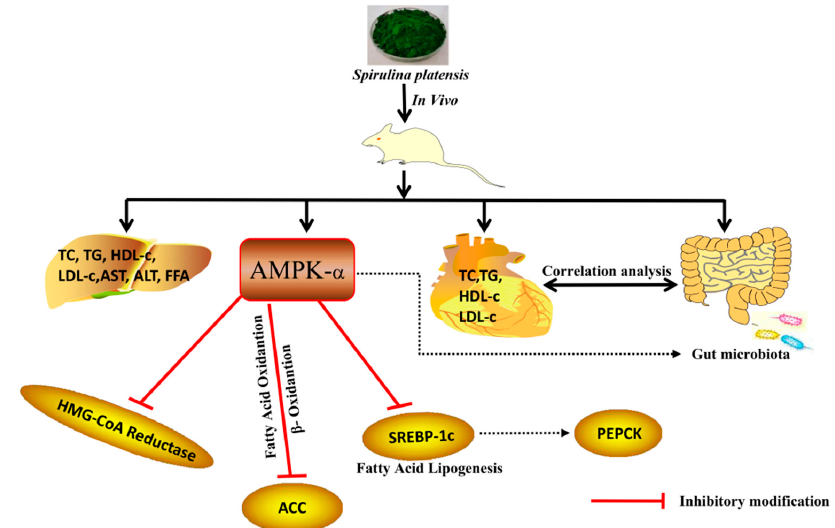
Figure 7. Summary of the mechanism of SPL95 to prevent LMD. Note: Stimulatory modification (green arrow), inhibitory modification (red arrow), and indirect modification (dotted arrow).